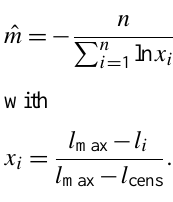
composed by post-Miocene lavas. We thus expect to infer the thermo-mechanical properties of the brittle crust from Weibull moduli estimated using the geometrical properties of the fault system. Those regions are characterized by differ- ent crustal thicknesses and thermic gradients. We assess the Weibull modulus as a measure of the distribution of faults in the brittle crust. The empirical Weibull moduli increase from Kenya to Afar, i.e. with decreasing crustal thickness and increasing thermal gradient (Fig. 3). This implies an increasing crustal strength from Kenya north to Afar. Here, we tentatively explain the increasing strength of the brittle crust with an increasing mechanical decoupling be- tween the brittle and ductile crust from Kenya to Afar as well as a decrease in structural heritage. The structural heritage will affect the crust by creating zones of weakness and there- fore reduce the crust’s maximum strength. The mode of de-